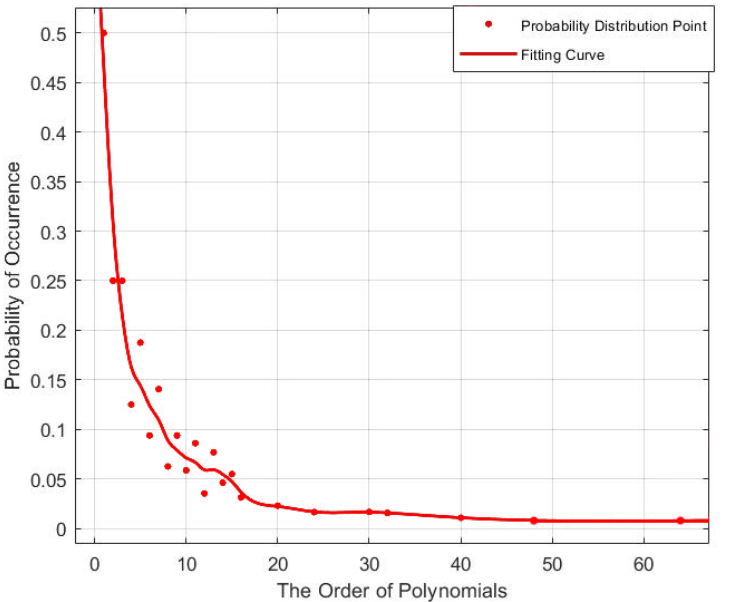
Figure 6. Proportion of primitive polynomials in all polynomials within the 64th degree, used a curve for